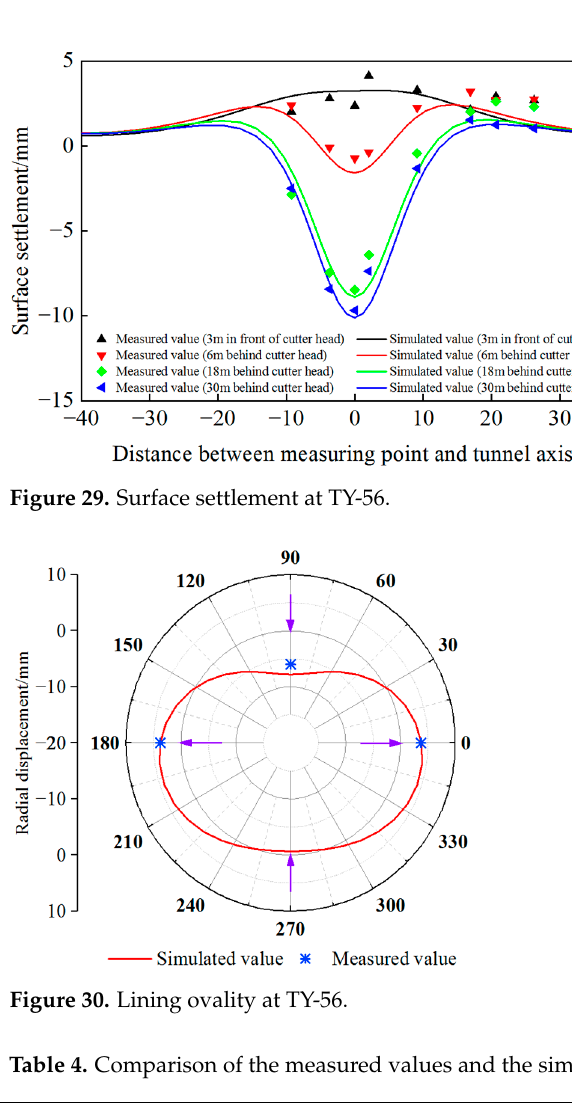
Figure 28. Excavation parameters at TY-56.